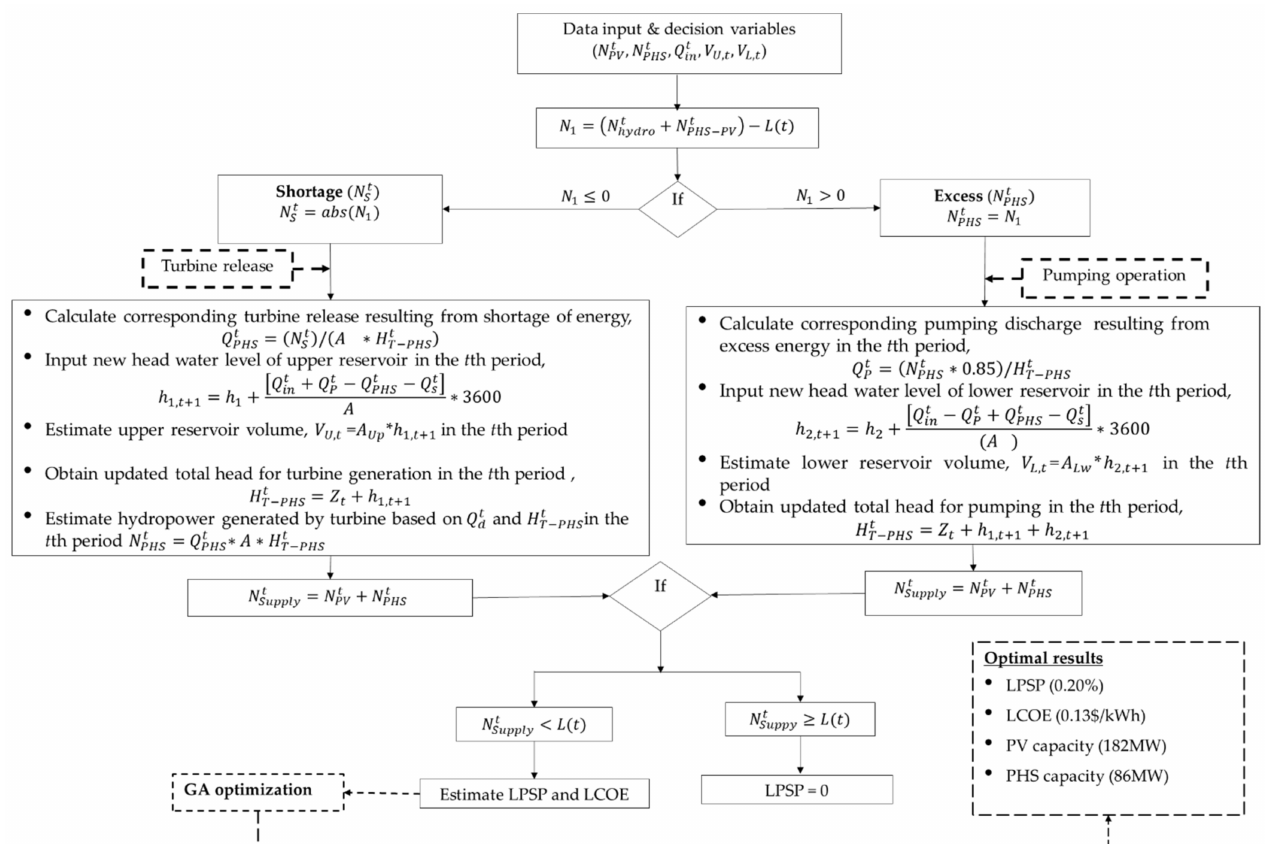
Figure 2. Illustration for system power supply mode.